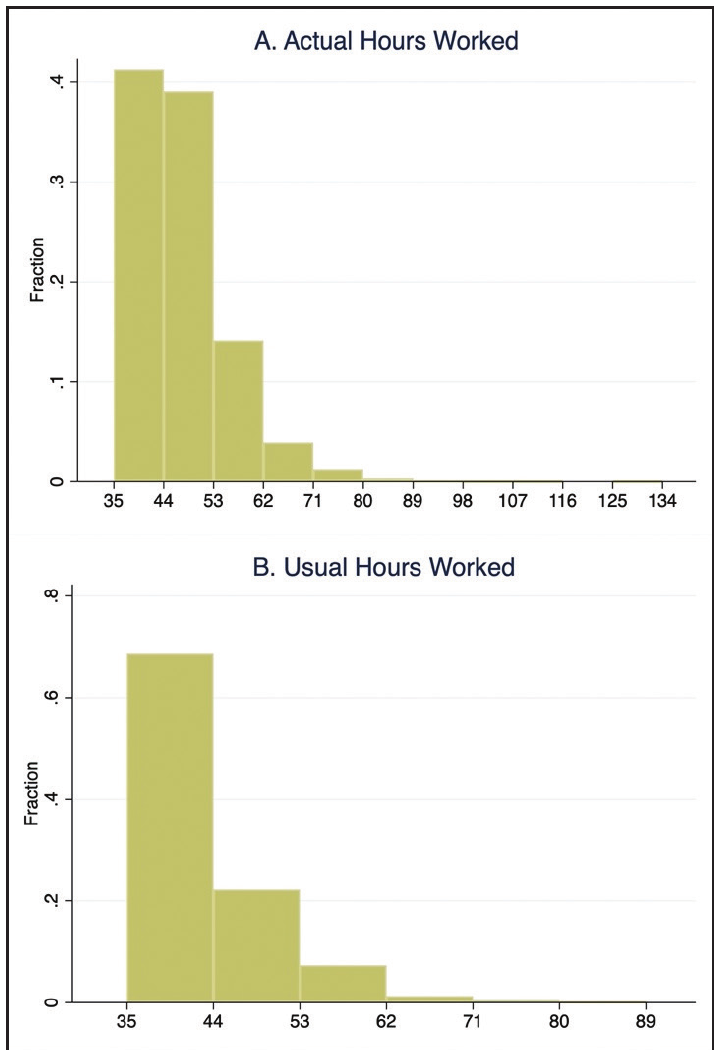
Figure 1 Distribution of hours worked before the policy